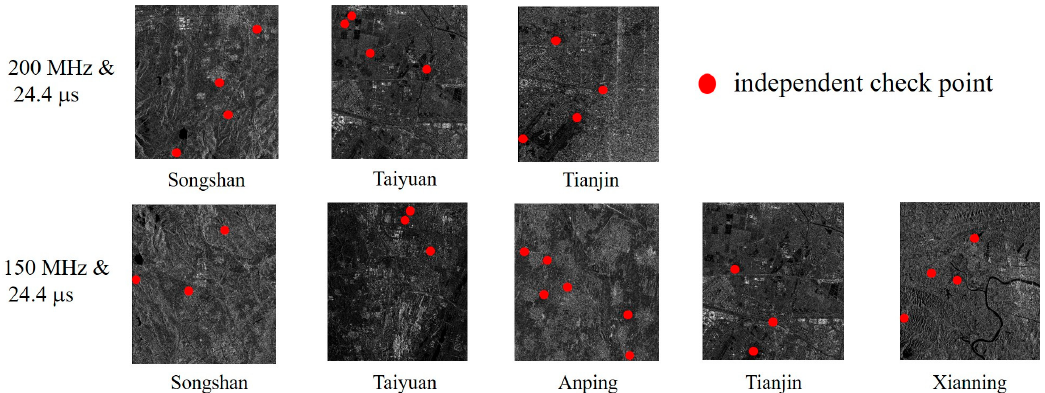
Figure 3. Distribution of independent check points (ICPs) in the validation images. Table 5. Image data used in Validation Groups A and B.